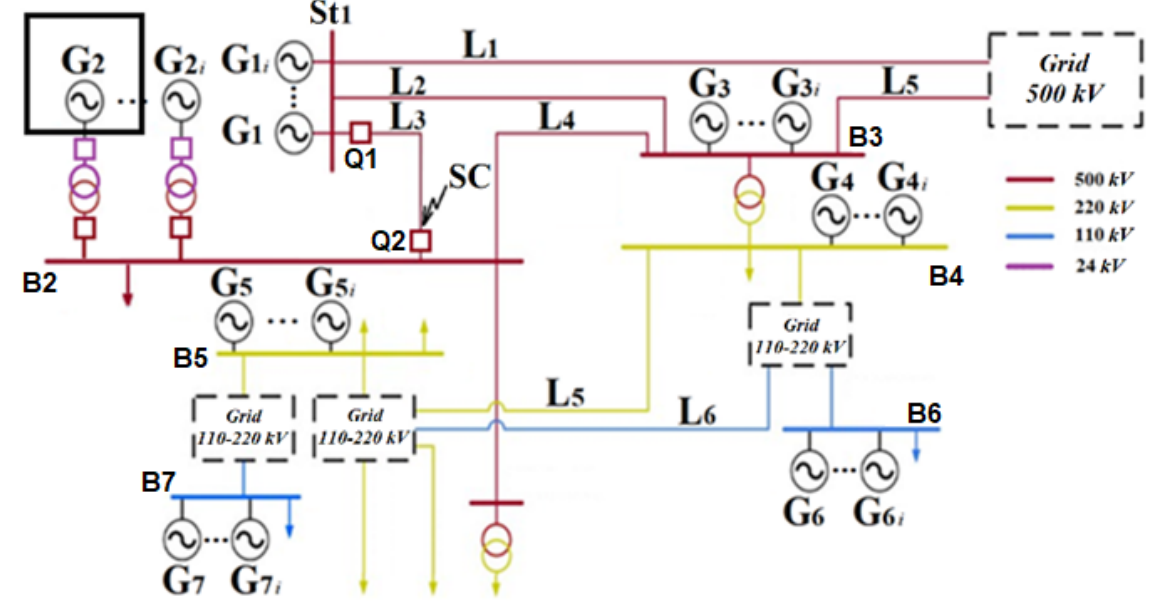
Figure 8. Single-line scheme of the simulated EPS. Figure 8. Single ‐ line scheme of the simulated EPS.